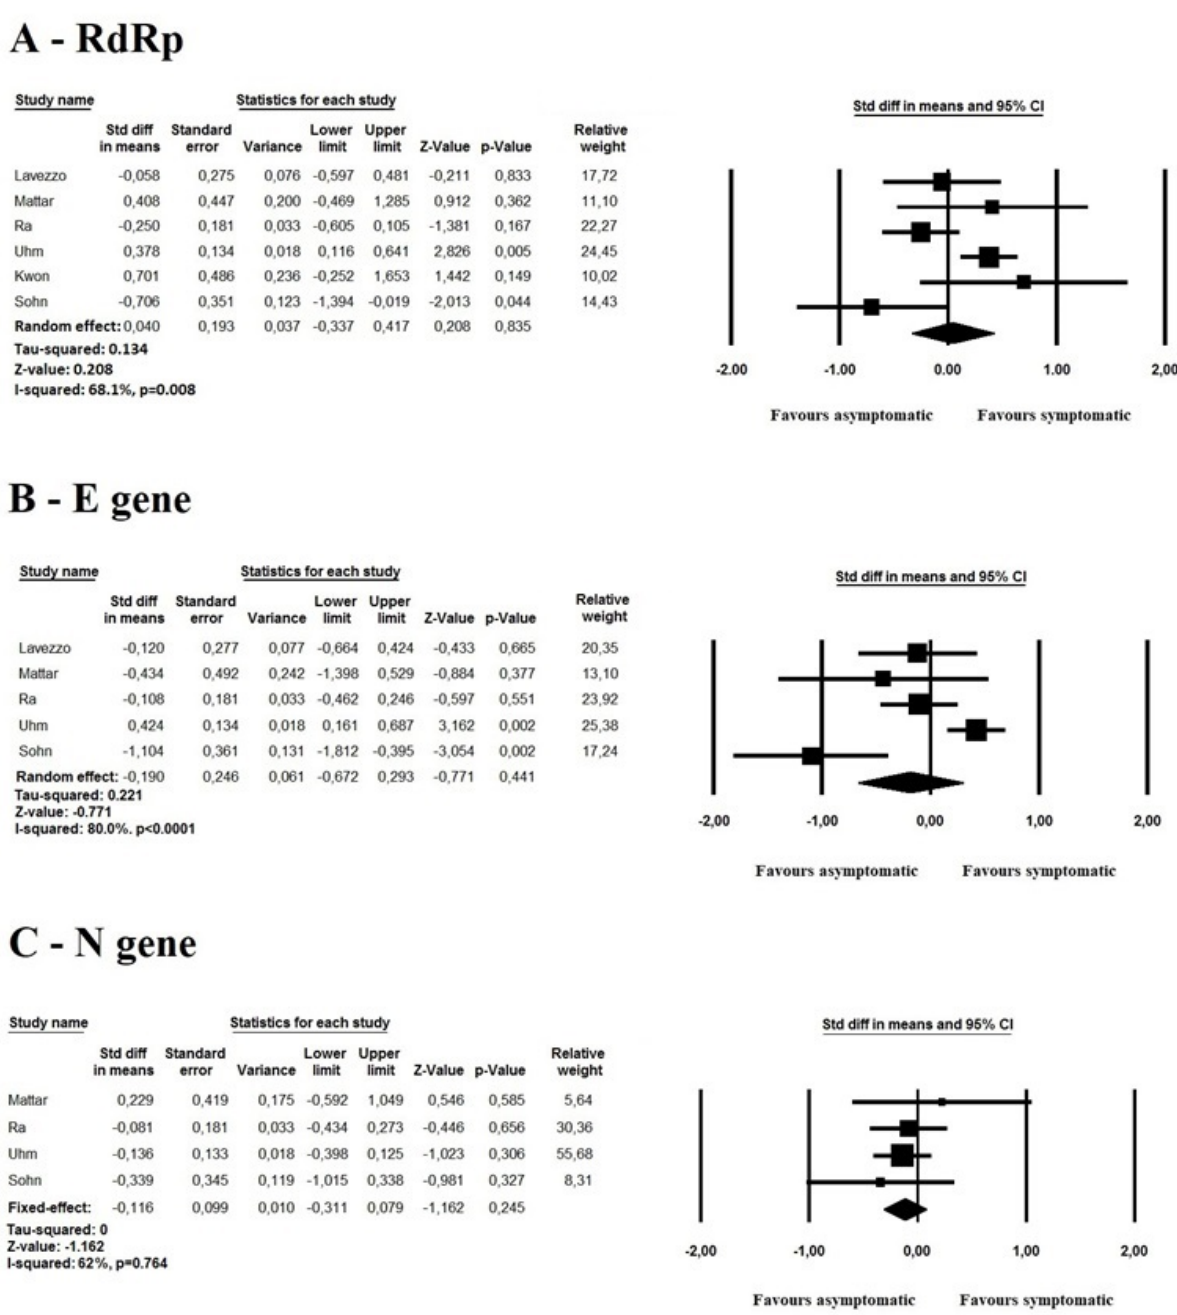
Figure 2. Forest plots of the standardized mean difference (SMD) between asymptomatic and symptomatic SARS-CoV-2 patients for the RdRp (Panel A), E (Panel B) and N genes (Panel C). The standard mean difference (Std diff in means), relative standard error and the corresponding 95% confidence interval are reported for each study. The relative weight of the studies in each model is also reported.